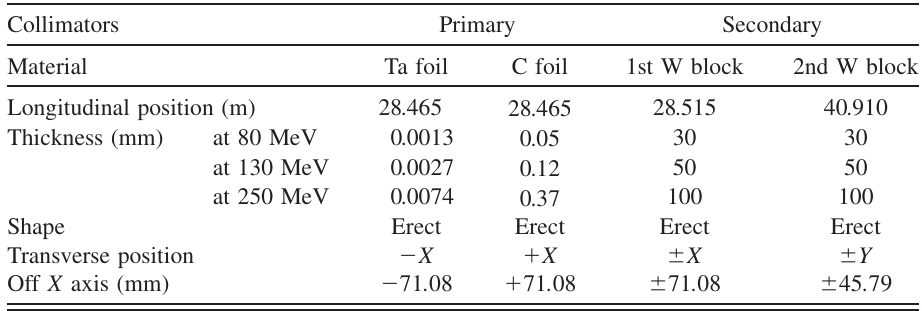
TABLE V. Parameters of the momentum collimators for the CSNS RCS.